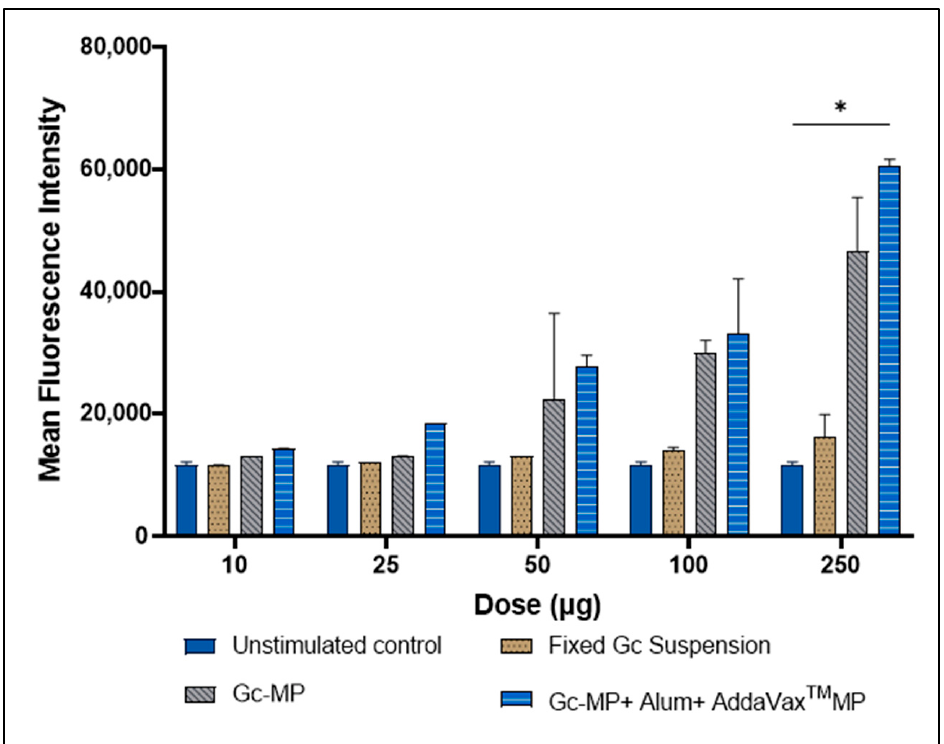
Figure 6. Induction of the surface expression of CD95 on dendritic cells induced with different treatments. DC 2.4 cells (5 × 10 4 cells per well) were exposed to increasing doses of Gc-MP (10, 25, 50, 100 and 250 µg/well) alone or combined with adjuvants (Alum MP or AddaVax™ MP), or inactivated or fixed whole-cell gonococci in suspension (100 µg/well), then incubated at 37 °C for 24 h. The expression of CD95 receptor was measured using flow cytometry. All data points were repeated as two independent experiments with three replicates in each experiment. Data are expressed as mean ± SD, Two-way ANOVA, post-hoc Dunnett’s multiple comparison test. * p < 0.05 significant.